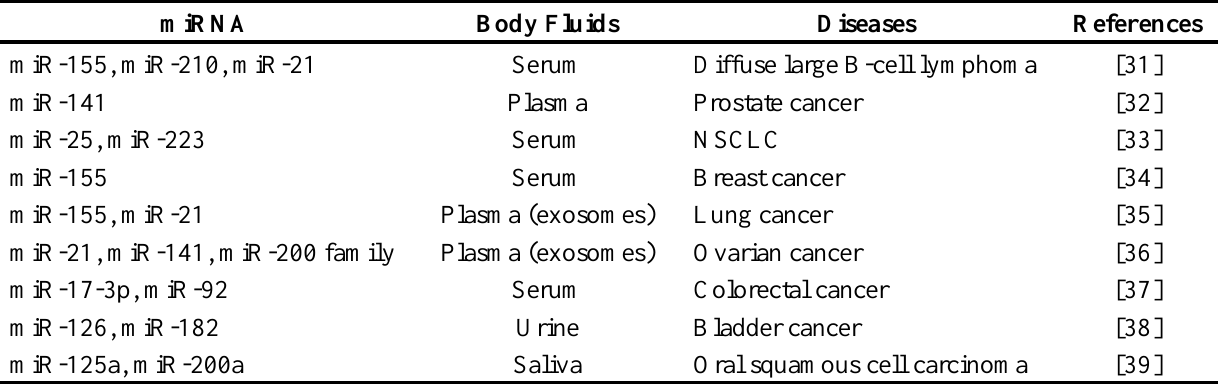
Table 1. Circulating miRNAs upregulated in